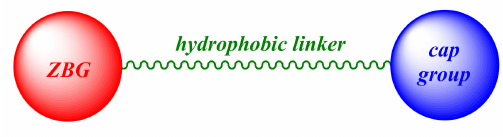
Figure 2. General structure of